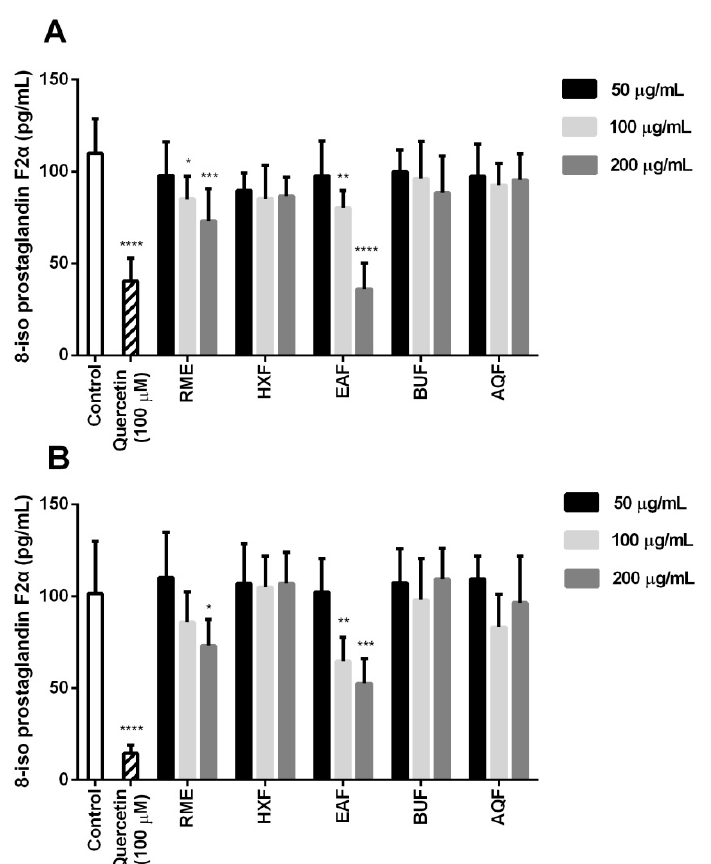
Figure 5. 8-isoprostaglandin F2 α concentrations under the influence of ( A ) AAPH and ( B ) H 2 O 2 . Data are expressed as the mean ± the standard deviation ( n = 6) following triplicate experimentation. * p < 0.05, ** p < 0.01, *** p < 0.001 and **** p < 0.0001 compared to the